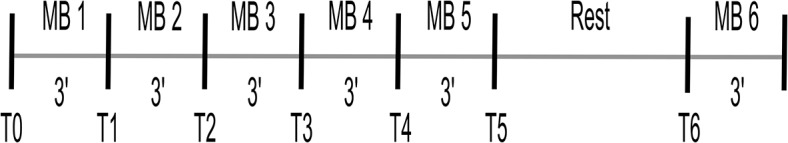
Schematic representation of the experimental design.(MB = Movement bout; T = testmoment; ‘ = minute).